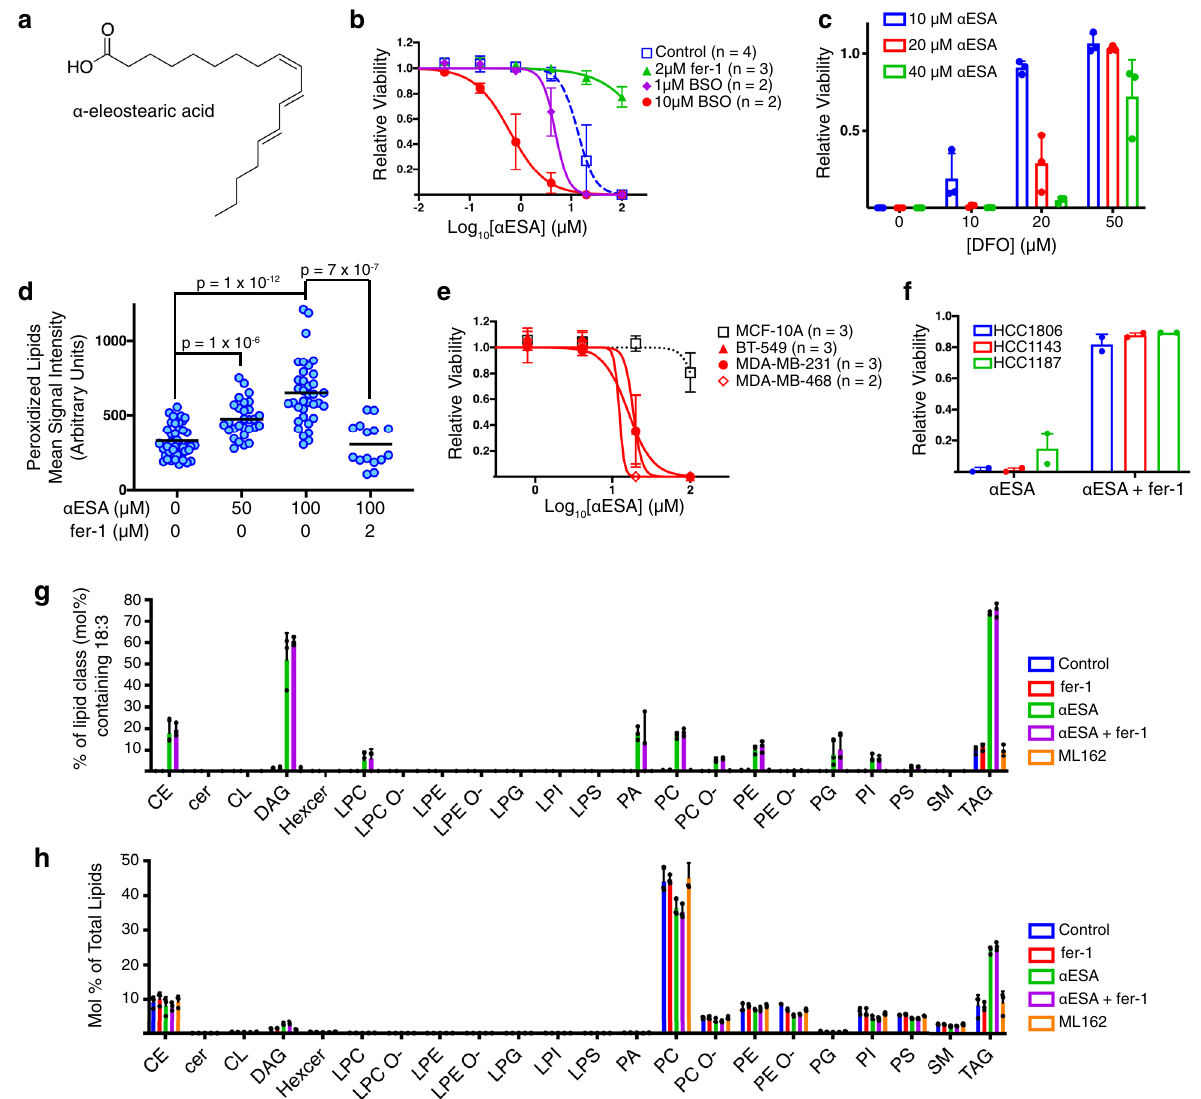
Fig. 2 The conjugated linolenic fatty acid α -eleostearic acid is incorporated into cellular lipids and induces ferroptosis. a Structure of α -eleostearic acid ( α ESA). b Cell viability dose-response curves for α ESA and the speci fi ed additional compound in MDA-MB-231 cells. Cells were treated for 72h. Error bars in this and subsequent panels represent standard deviation centered on the mean. c Relative viability of MDA-MB-231 cells incubated with the indicated doses of α ESA and DFO for 72h ( n = 3 independent experiments). Values were normalized to account for loss of viability associated with DFO. d Quantitation of lipid peroxidation products in individual cells after 4 h of treatment with the speci fi ed agent. The line indicates the mean. From left to right, n = 42, 29, 36, and 15. p values from two-sided Student ’ s t tests are shown. e Cell viability dose-response curves for α ESA for three TNBC cell lines (red lines) and non- cancerous MCF-10A controls (black dashed line) after 72h of treatment. f Relative cell viability for three TNBC cell lines after 72 h of treatment with α ESA or the combination of α ESA and fer-1 (2 μ M) ( n = 2 independent experiments). The dose α ESA was 100 μ M for HCC1806 and HCC1143 and 20 μ M for HCC1187. g Percent of the mole fraction for each of the indicated classes of lipid that contain 18:3 (18 carbon, 3 double bonds) fatty acids consistent with α ESA ( n = 3 biological replicates for each condition). h Mole percent of each lipid class as a fraction of total lipids in MDA-MB-231 cells incubated with vehicle, 2 μ M fer-1, 50 μ M α ESA, 50 μ M α ESA and 2 μ M fer-1, or 250 nM ML162 for 3 h ( n = 3 biological replicates for each condition). CE = cholesterol esters, Cer = ceramide, DAG = diacylglycerol, Hexcer = hexosylceramide, LPC = lysophosphatidylcholine, LPC O- = ether-linked lysophosphatidylcholine, LPE = lysophosphatidylethanolamine, LPE O- = ether-linked lysophosphatidylethanolamine, LPG = lysophosphatidylglycerol, LPI = lysophosphatidylinositol, LPS = lysophosphatidylserine, PA = phosphatidate, PC = phosphatidylcholine, PC O- = ether-linked phosphatidylcholine, PE = phosphatidylethanolamine, PE O- = ether-linked phosphatidylethanolamine, PG = phosphatidylglycerol, PI = phosphatidylinositol, PS = phosphatidylserine, SM = sphingomyelin, TAG = triacylglycerol. Source data are provided as a Source Data fi antioxidant 9,10 . As expected, iFSP1, a small-molecule inhibitor of ML162-triggered ferroptosis (Fig. 4g) and α ESA-induced ferrop- tosis, though the resistance to ferroptosis triggered by α ESA was FSP1 9 , enhanced cell killing by ML162 in both BT-549 and less robust in BT-549 cells (Fig. 4h). MDA-MB-231 cells (Fig. 4i). By contrast, iFSP1 had no effect on α ESA toxicity in BT-549 cells, but enhanced cell death in MDA- FSP1 mediates a second pathway for hydroperoxide neutraliza- tion that operates in parallel to GPX4. By reducing coenzyme Q 10 , MB-231 cells (Fig. 4j), highlighting a further distinction between FSP1 maintains an active pool of this radical-trapping lipophilic ferroptosis induced by α ESA and canonical ferroptosis inducers.